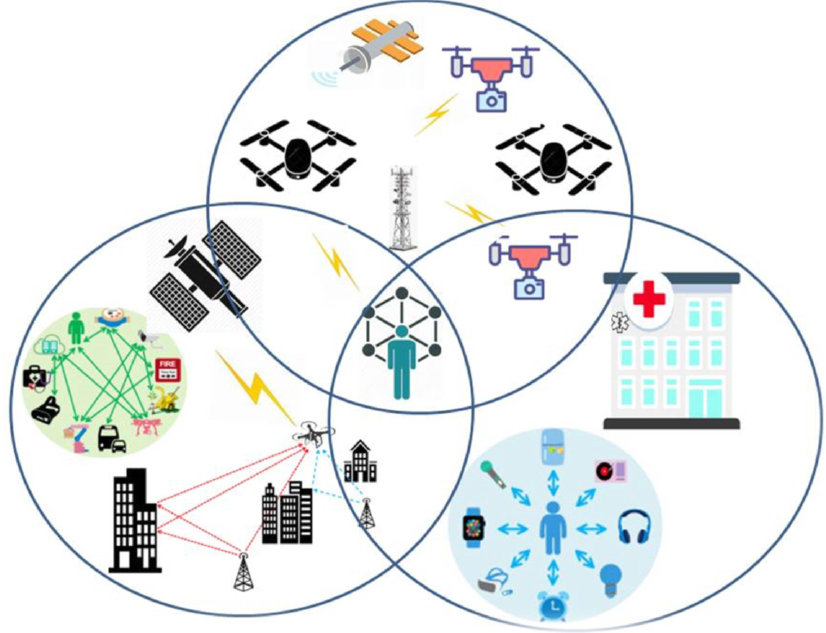
Figure 1. Illustration of future UAV applications in 5G and beyond network environments.